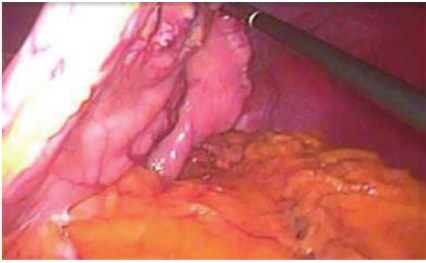
Figure 2: Elevation of the stomach.